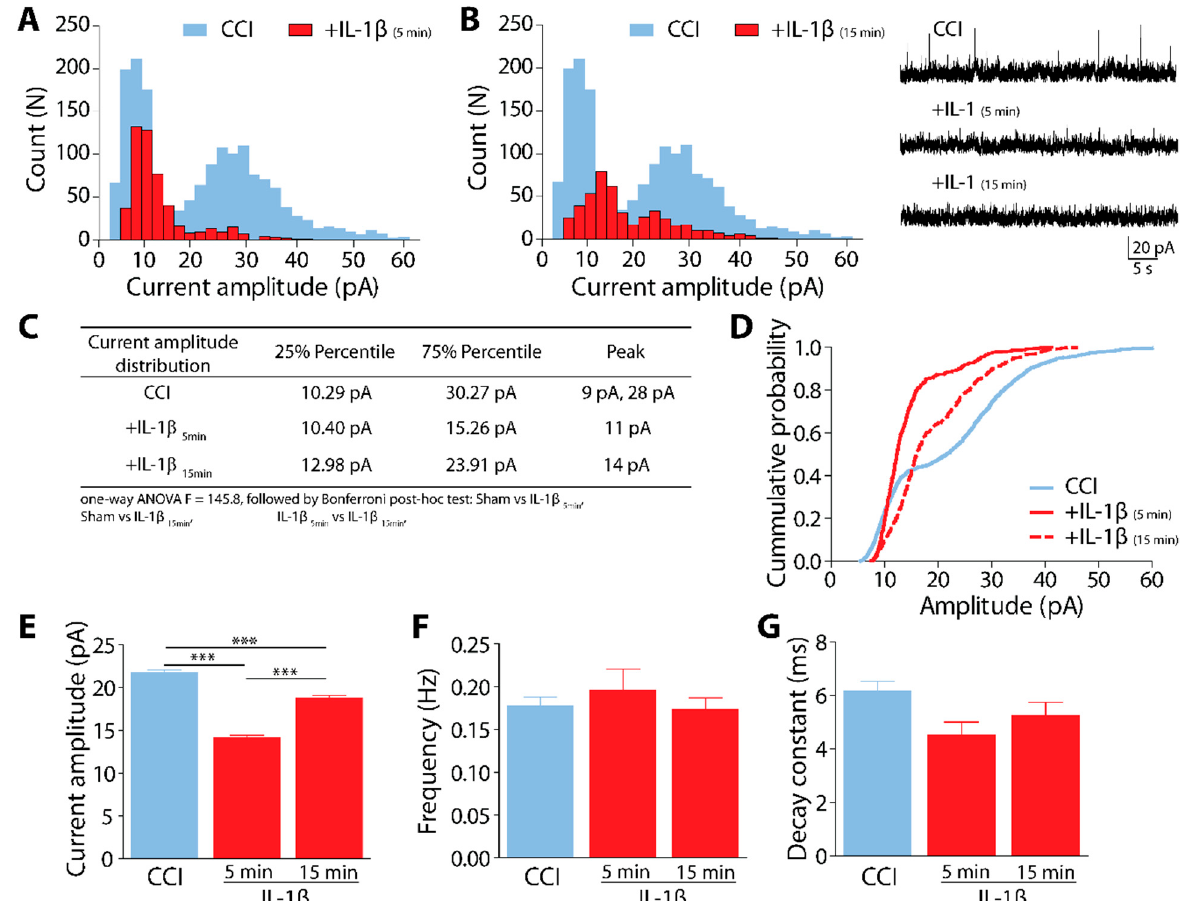
Figure 3. Glycinergic sIPSCs in CeA slices from CCI animals are differentially modulated by IL-1 β . ( A , B ) Spontaneous current amplitude distribution plots for CCI slices, before and after 5 min ( A ) or 15 min ( B ) IL-1 β (10 ng/mL). Inset: representative synaptic sIPSC glycinergic currents in the presence of CNQX (10 μ M), APV (50 μ M), bicuculline (10 μ M), clamped at +20 mV. ( C ) the table summarizes the distribution data from ( A , B ). ( D ) Cumulative probability histogram of amplitude in CeA neurons in CCI, before (blue line) and after 5 min (continuous red line) and 15 min (discontinuous red line) of IL-1 β . ( E – G ) Comparative plots of the glycinergic sIPSC currents parameters, as mean ± SEM, *** p < 0.001 (n = 5 CCI, 10 cells; 10 cells + IL-1 β ).